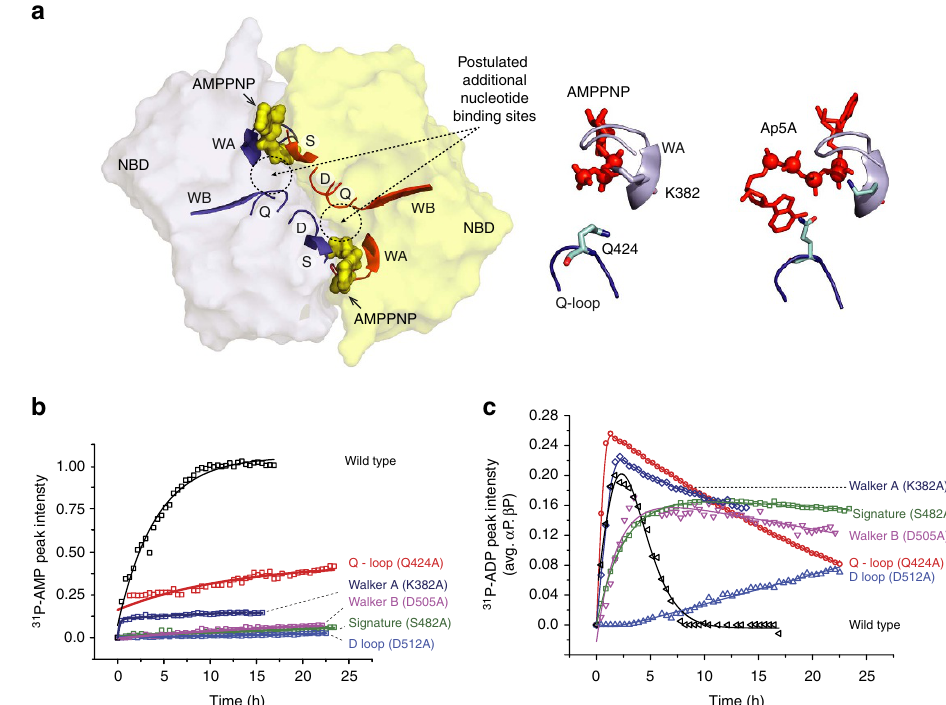
Figure 5 | Mutational analysis of the coupled ATPase-AK activity of MsbA. ( a ) Visualization of the conserved NBD sequence motifs in the MsbA/AMP.PNP crystal structure (pdb: 3B60). The canonical binding sites and a second postulated binding sites are highlighted. Key residue K382 in Walker A is in close proximity to the nucleotide phosphate groups (top middle). In pfSMC NBD , the Q-loop glutamine was found coordinating binding of Ap5A indicative of a second binding site (top right, pdb: 3KTA). All single-point mutations are summarized in Table 1. ( b ) Progress curves of the 31 P-AMP peak intensities demonstrate much reduced generation of AMP. The initial data points of Q424A are missing due to the experimental dead time. ( c ) Progress curves of the 31 P-ADP peak intensities are sensitive to both the ATPase (positive slope) and kinase (negative slope) reactions. The mutation Q424A causes accelerated ADP generation (ATPase) but slower consumption (kinase) with respect to wild-type MsbA. The ADP consumption is even slower in case of K382A. The S482A and D505A mutations slow down both ATPase and kinase activity. The D512A mutation causes the slowest ADP generation, whereas no consumption of ADP could be seen on the time scale of the experiment. Experiments were done in triplicate with protein samples from different expressions each time.